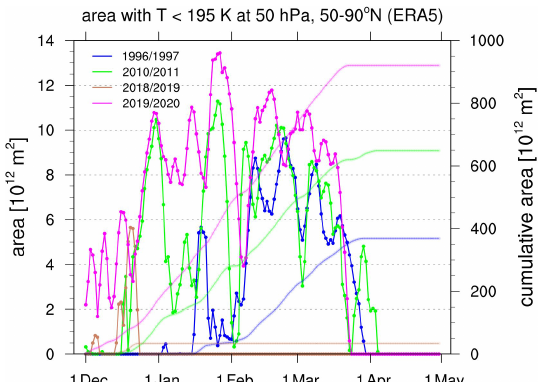
Figure 7. Daily area (in 10 12 m 2 ) with temperature less than 195K at 50hPa (about 20km altitude) in the region 50–90 ◦ N from 1 De- cember to 30 April based on ERA5 data (solid lines). Daily cumu- lative values are indicated as faint lines. The Northern Hemisphere winters 1996/1997, 2010/2011, 2018/2019, and 2019/2020 are dis- played by blue, green, brown, and magenta lines, respectively. For simplicity, the leap day in 2020 (29 February) was neglected in the daily time series.